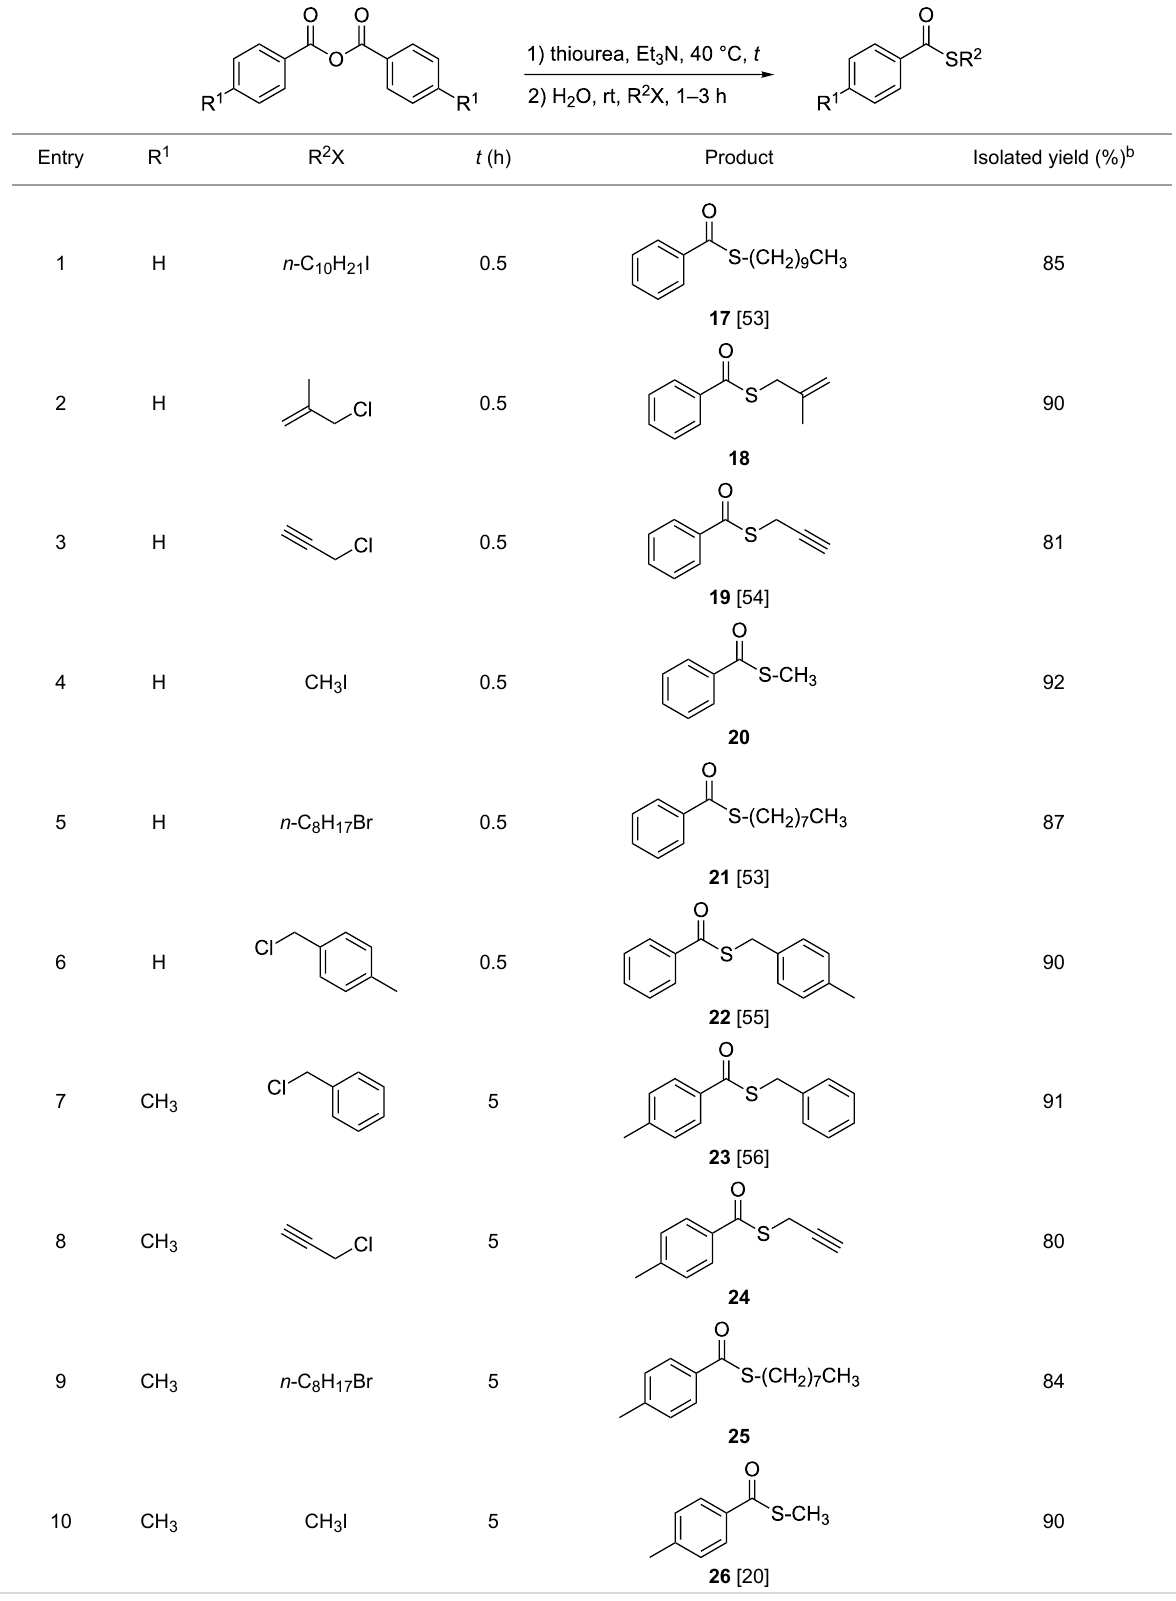
Table 2: One-pot synthesis of thioesters using benzoic anhydrides, thiourea and alkyl halides a